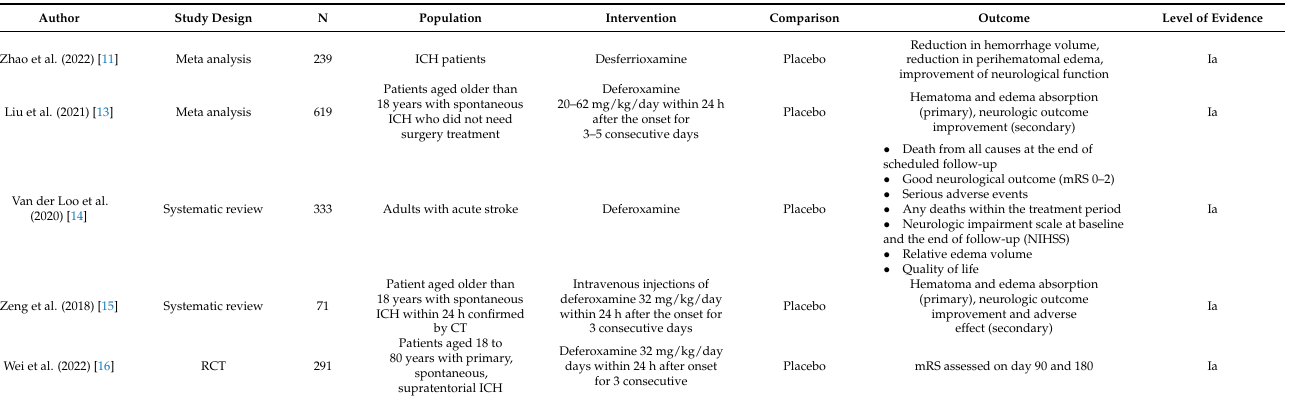
Table 1. Characteristics of included